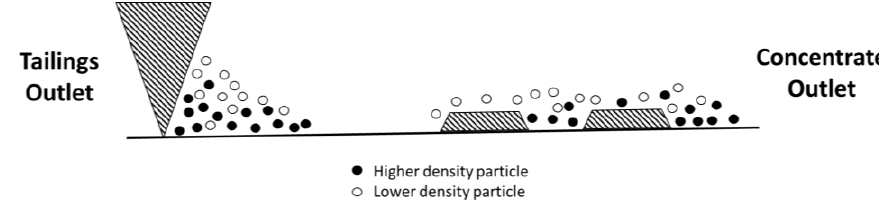
Figure 5. Cross-sectional view of scraping blades. Conventional scraping blade system is shown on the left and the novel, low profile scraping blades on the right.